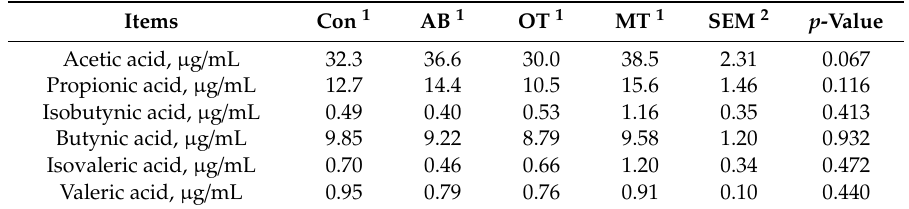
Table 5. E ff ect of dietary supplementation with tributyrin in combination with di ff erent essential oils on short-chain fatty acid in the colon of weaned pigs.